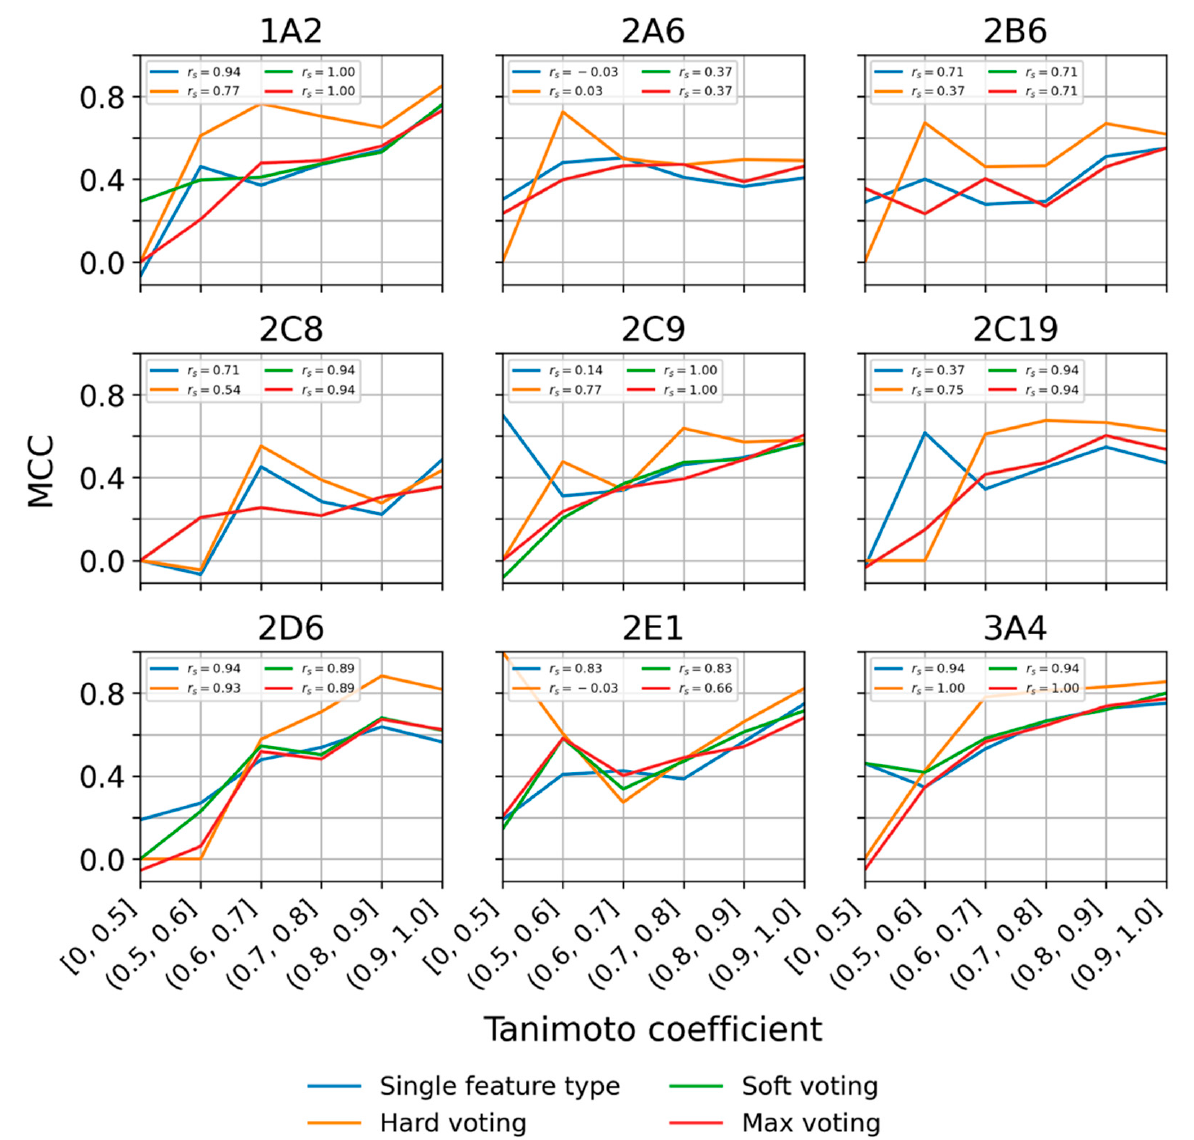
Figure 5. Model performance (quantified as MCC) as a function of molecular similarity between the compounds of the validation set and the nearest neighbor in the training set (quantified by the Tanimoto coefficient based on MACCS keys). Spearman’s rho values are reported in the figure legends.